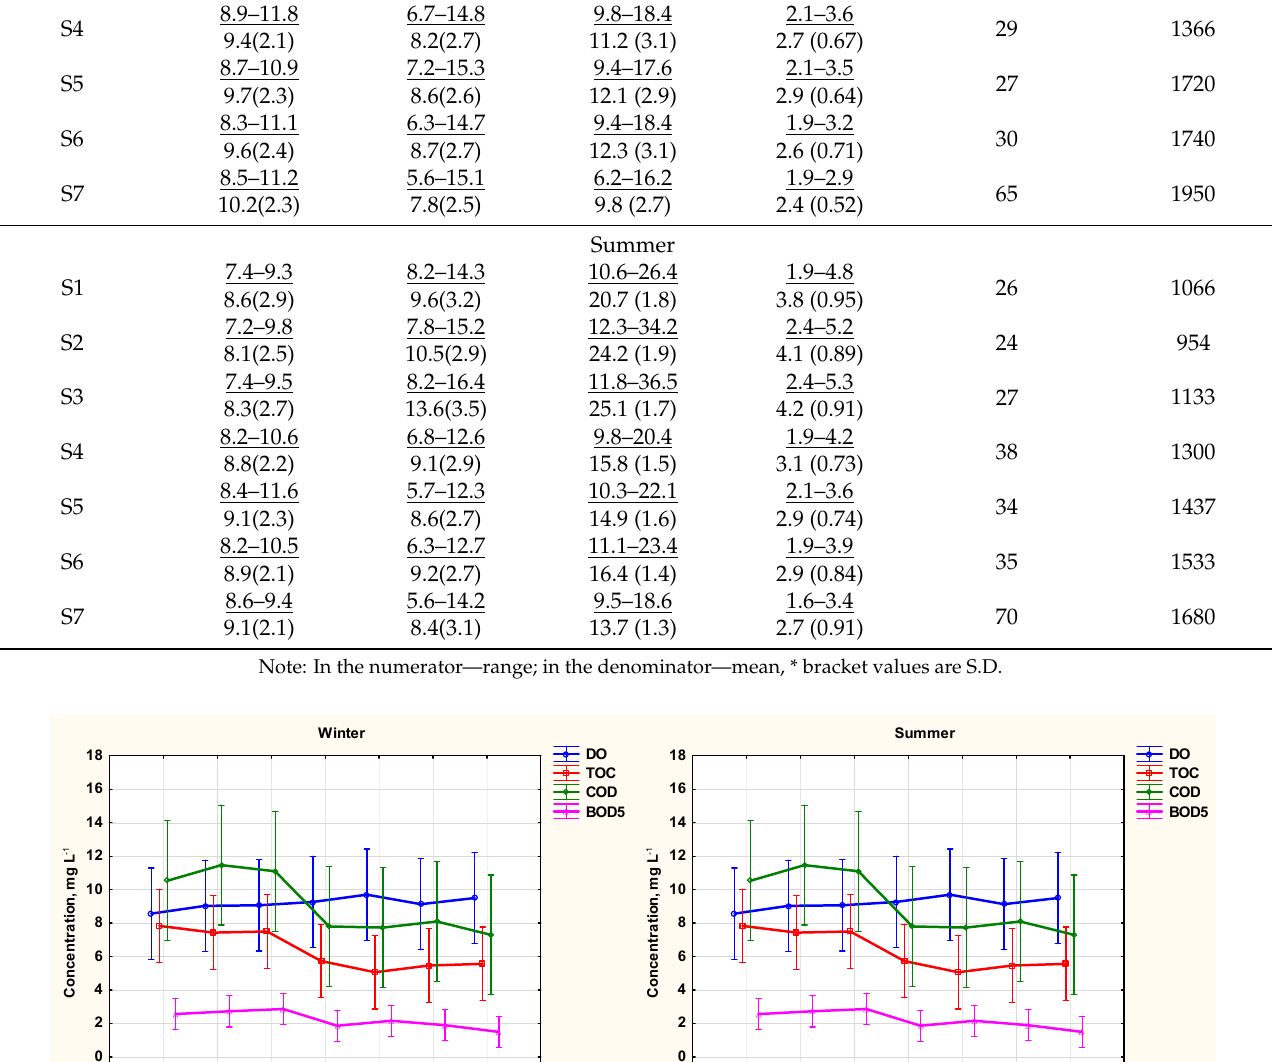
Figure 4. The varying concentrations of dissolved oxygen, chemical oxygen demand, total nitrogen, and total phosphorus at the sampling sites in the summer of 2016.